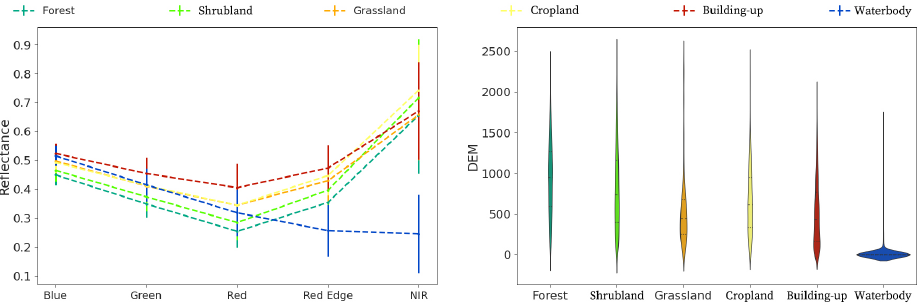
Figure 10. Spectral and topographic features for each